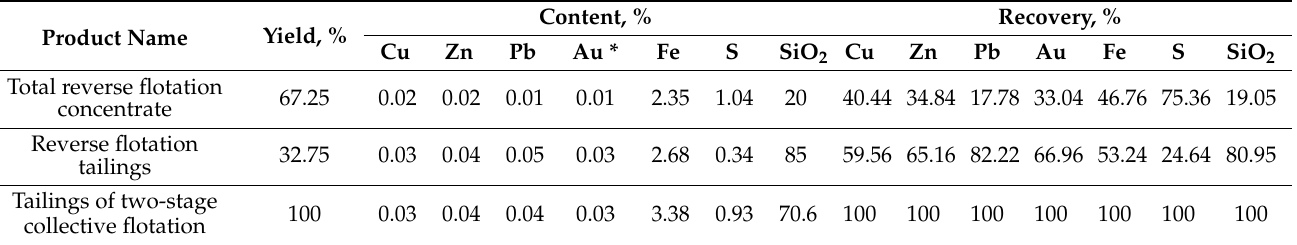
Table 6. The results of reverse flotation of collective